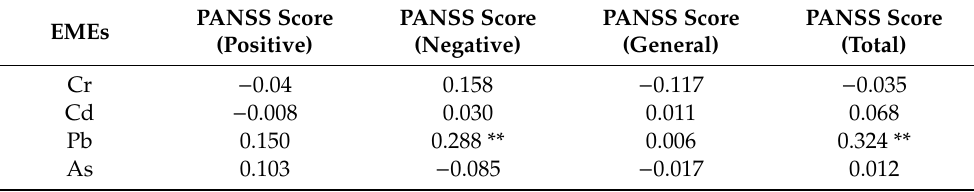
Table 4. Spearmancorrelations(rho)ofPANSSscoreandconcentrationofTHMsinschizophreniapatients.